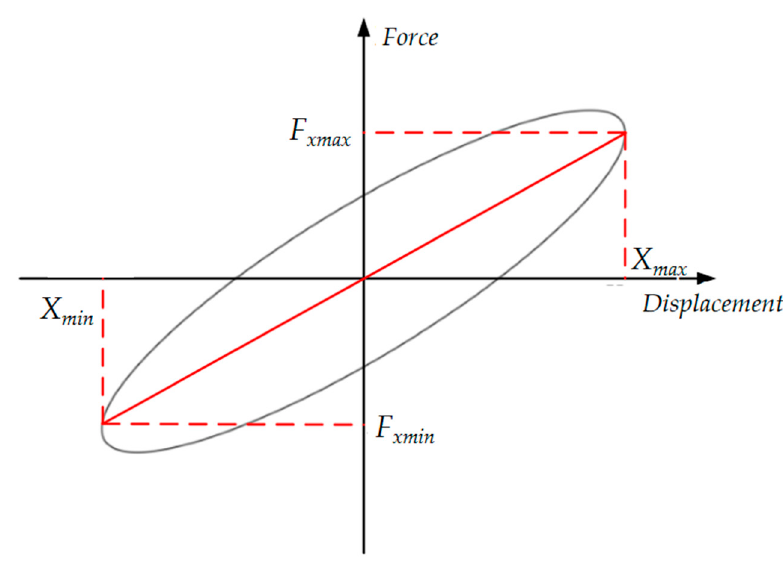
Figure 8. Trend of the magnetic induction strength with the current.